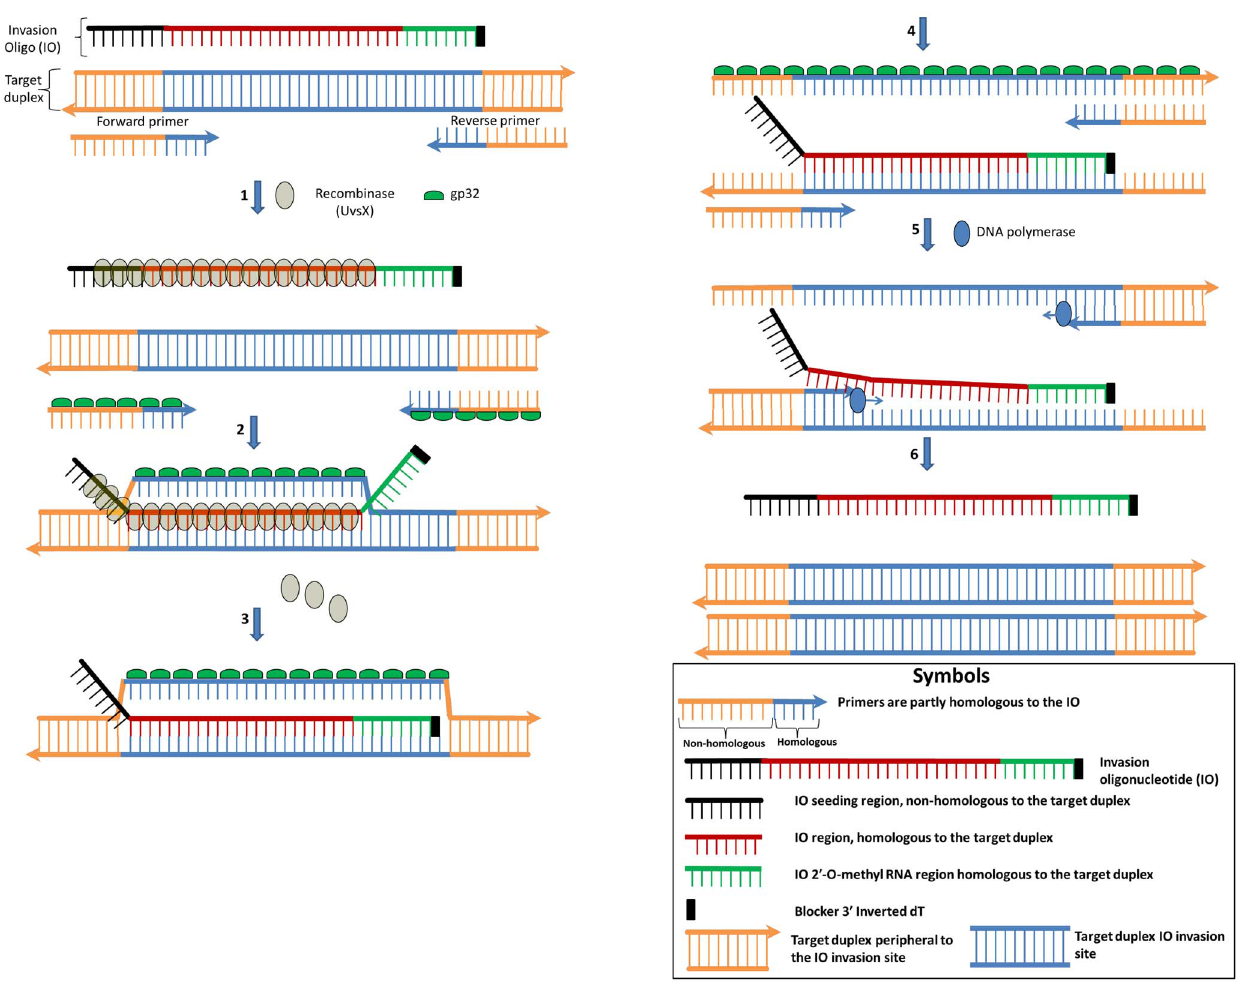
Figure 1. Mechanistic description of the SIBA reaction. All single-stranded elements are coated with gp32, except for the 2 9 -O-methyl RNA nucleotides. Step 1: UvsX displaces gp32 on the IO and only weakly coats the primers, since they are too short for high affinity binding. Step 2: The IO invades the complementary region of the target duplex which allows partial separation of the target duplex with the downstream end still remaining double-stranded. The out-going strand of the partially separated target duplex is stabilized by gp32. Step 3: UvsX depolymerization allows the 2 9 -O-methyl RNA region of the IO branch migrates into the duplex. Step 4: Both the upstream and downstream region peripheral to the IO also become short enough to dissociate. Step 5: The strand displacement polymerase is able to extend the dissociated target duplex from the primers. The forward primer displaces the IO during extension of the target template. Step 8: These events lead to the production of two copies of the target duplex. The IO is released to induce further